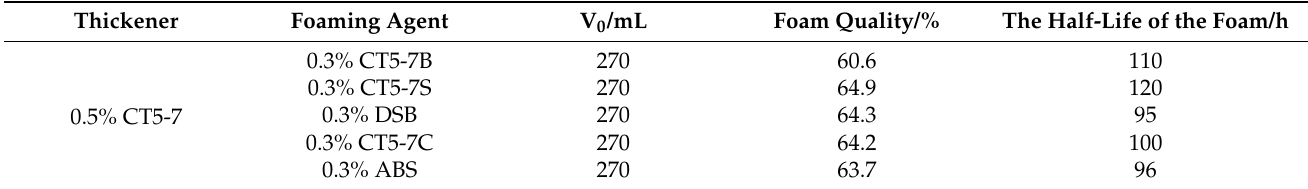
Table 3. Evaluation of foaming and foam stabilizing properties of the foaming agent. Thickener Foaming Agent V 0 /mL Foam Quality/% The Half-Life of the Foam/h 0.3% CT5-7B 270 60.6 0.5% CT5-7